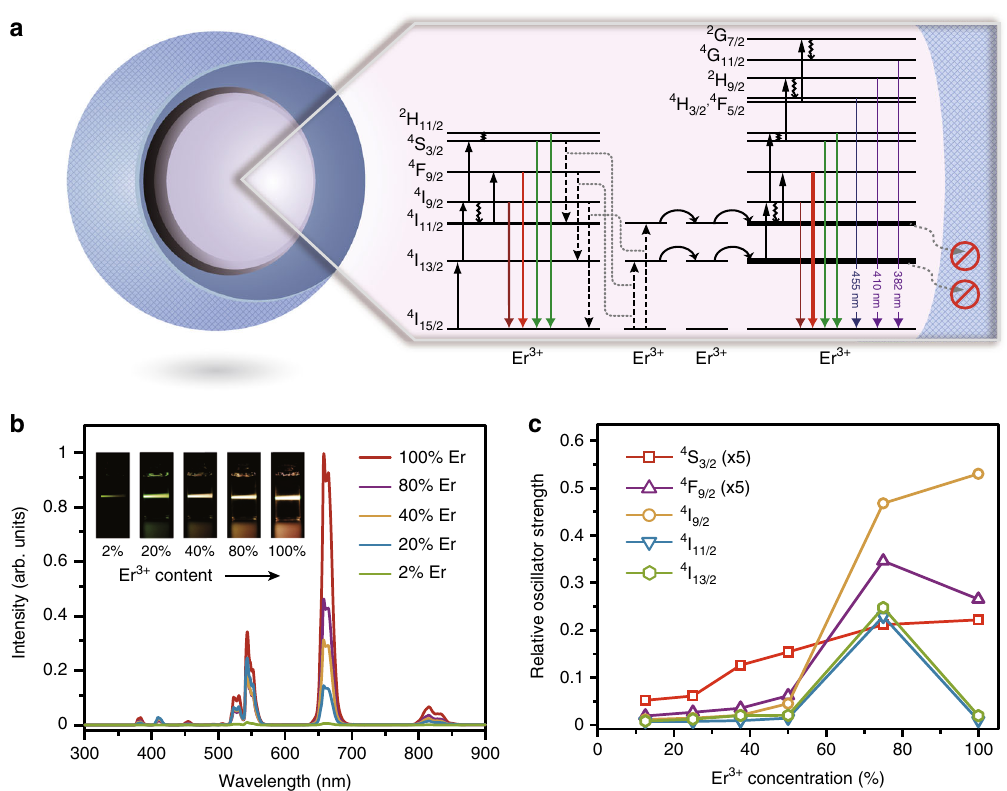
Fig. 3 Concentration quenching in the NaYF 4 :Er@NaYF 4 nanocrystals. a Proposed concentration quenching processes in NaErF 4 @NaYF 4 core − shell nanoparticles by 1532nm excitation. The full, wavy, and colored arrows represent excitation, multiphonon relaxation, and emission processes, respectively. b Emission spectra of NaYF 4 :Er (2 − 100 %)@NaYF 4 nanoparticles in cyclohexane dispersions (0.01M) as a function of Er 3 + concentration. All spectra were recorded under excitation of a 1532 nm CW diode laser at a power density of 21W cm − 2 . Inset: luminescence photographs of the corresponding nanoparticle colloids. c The relative oscillator strengths for different excited states as a function of Er 3 + concentration. Note that the concentrations in the theoretical calculation may not be exactly the same as that used in the experiments but still correctly illustrate the evolution of electronic transition